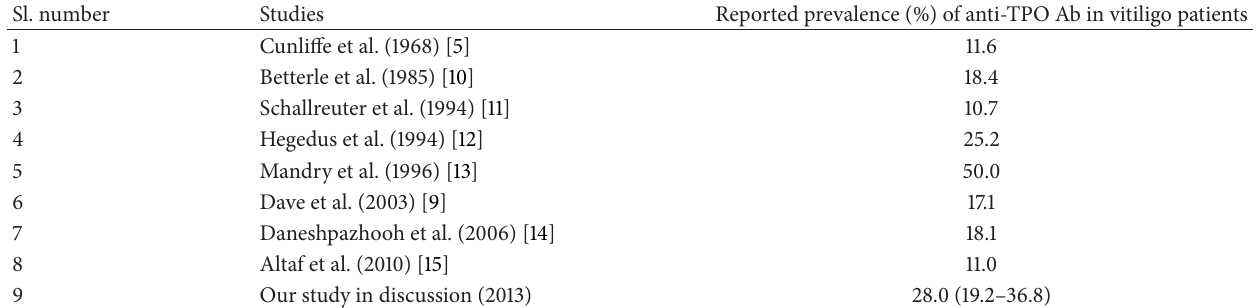
Table 3: Comparison of thyroid autoantibody profile in various